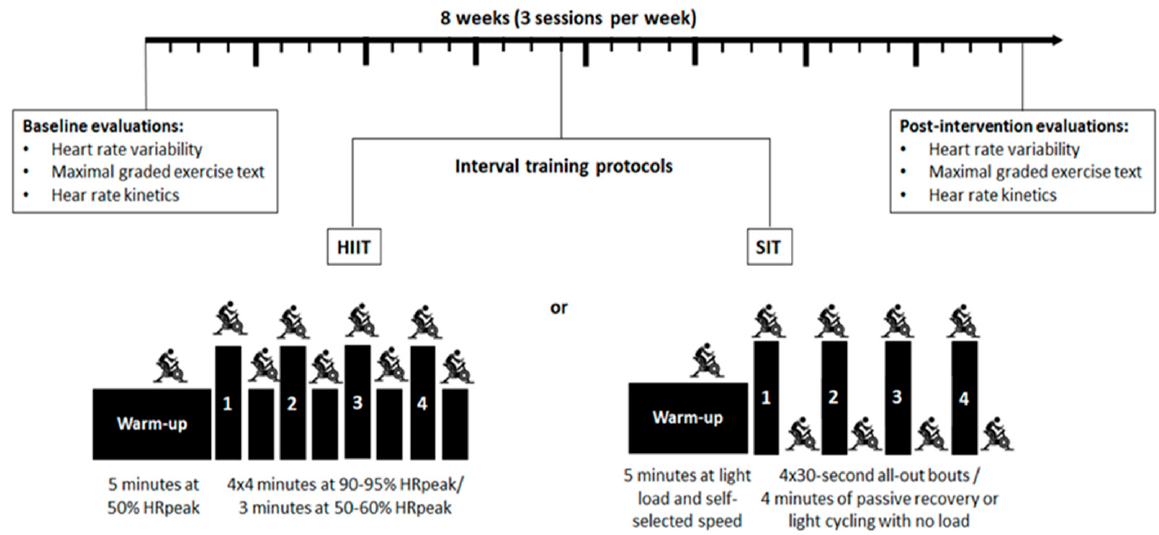
Figure 2. Study design. HIIT, high intensity interval training; SIT, sprint interval training. 1–4 effort sessions